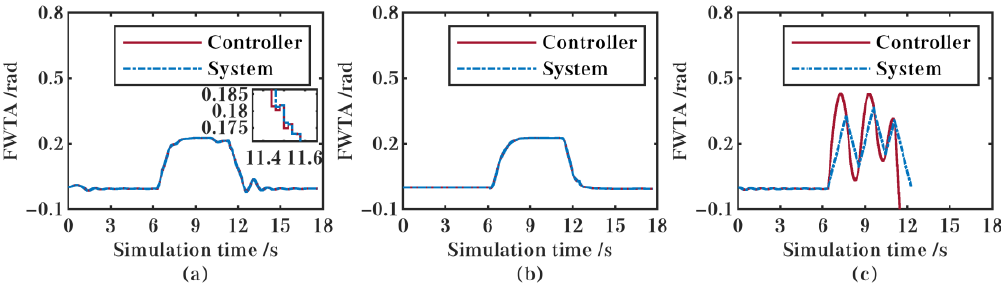
Figure 6. The front wheel turning angle of the comparison simulation: ( a ) the NN controller; ( b ) the NMPC controller; ( c ) the Stanley controller.